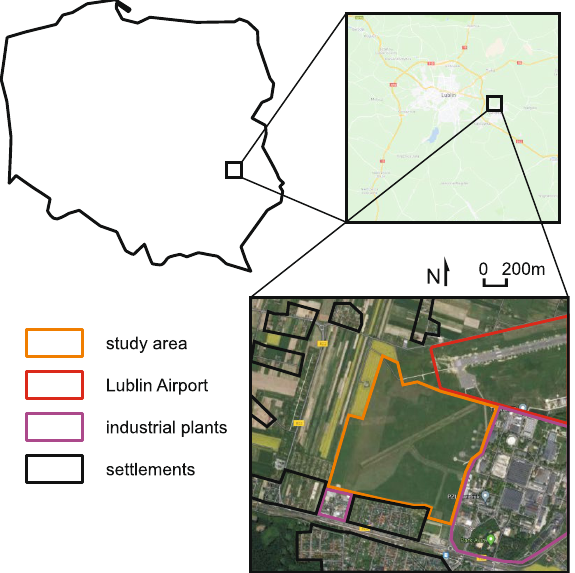
Figure 1. Location of the study area in Poland (Europe), the shape of the grass airfield, and its surroundings. The figure was generated in Google Earth Pro v7.3 (https:// earth. google. com) and CorelDRAW Standard 2020 (https:// www. corel.